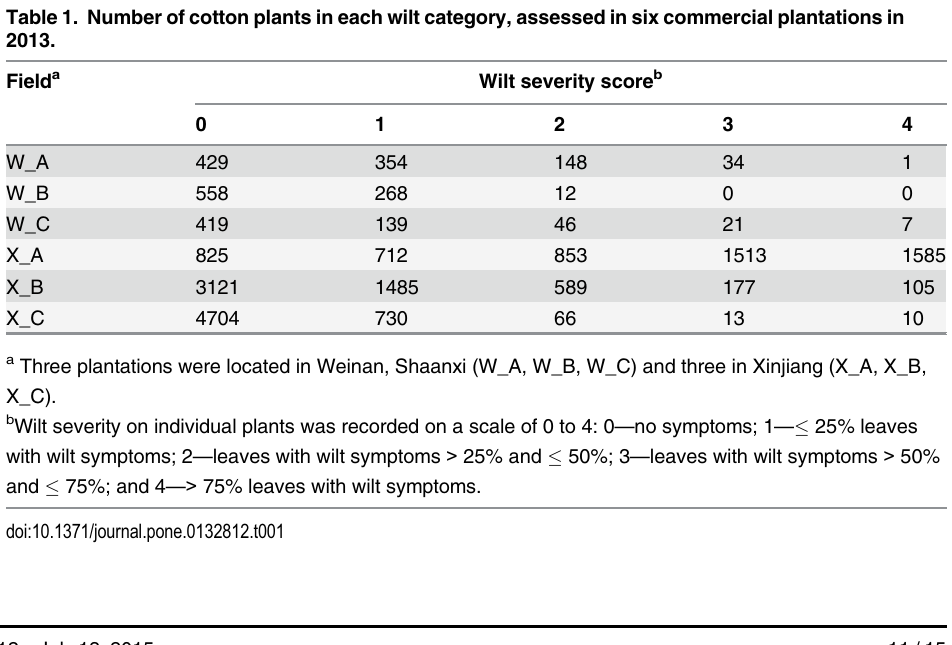
Table 1. Number of cotton plants in each wilt category, assessed in six commercial plantations in 2013. Field a